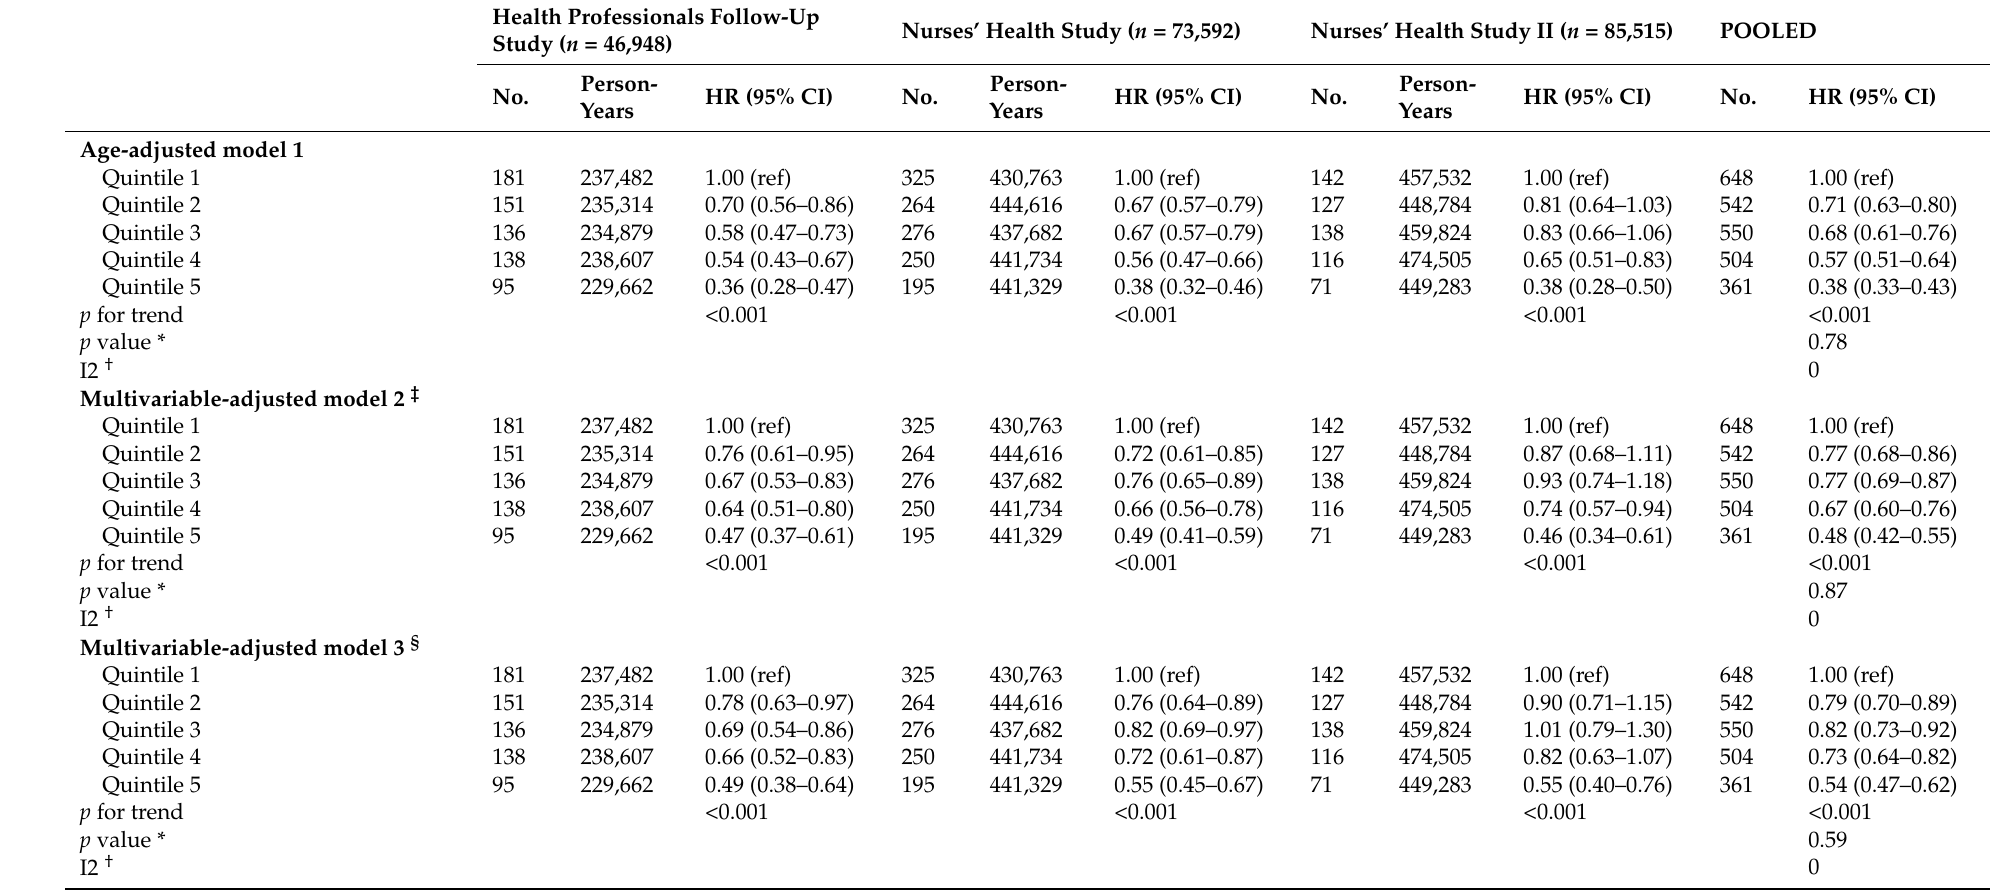
Table 3. Association between the healthful Plant-based Diet Index (hPDI) and the risk of newly-diagnosed chronic obstructive pulmonary disease in three cohorts